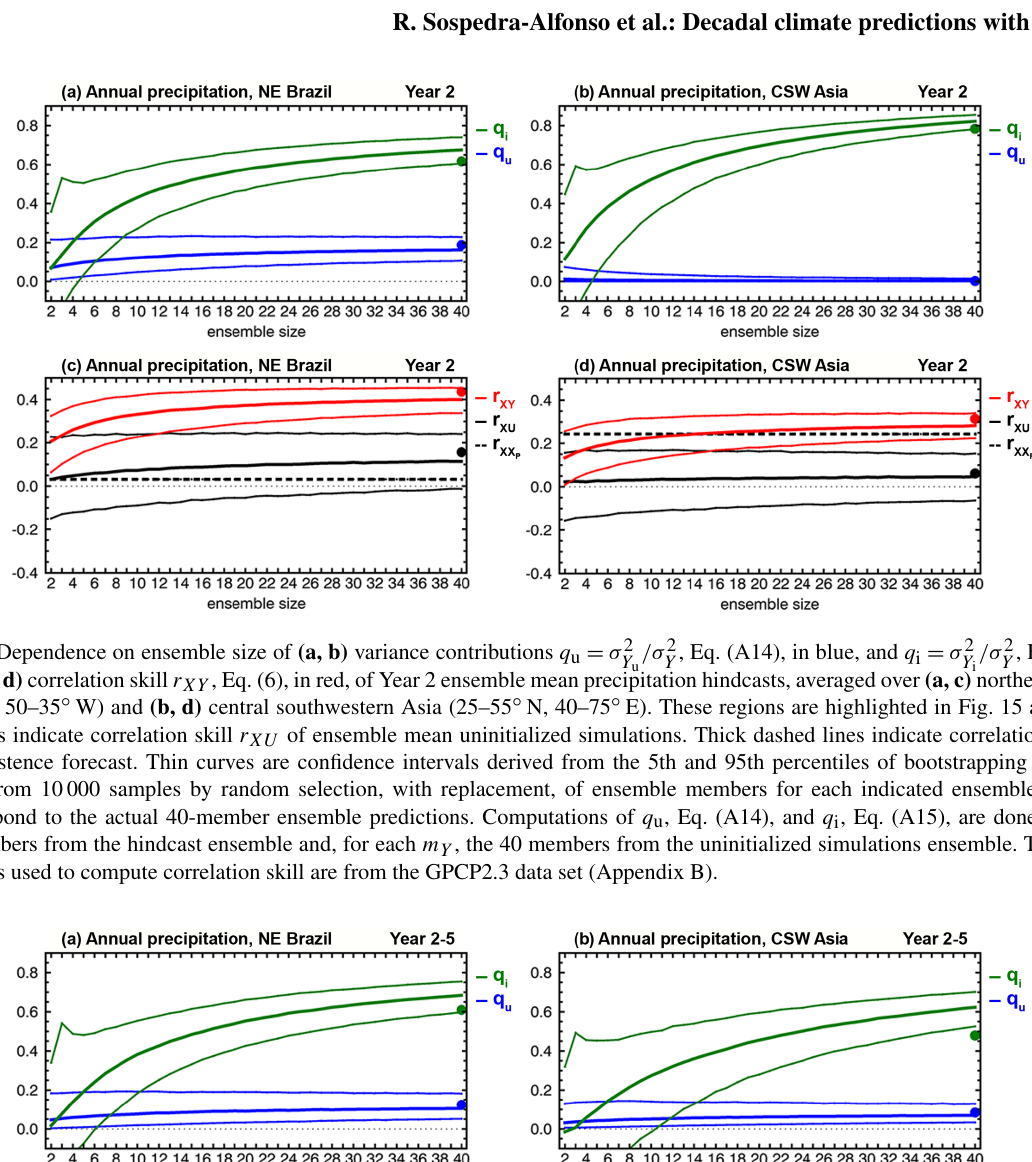
Figure 17. As in Fig. 16 for forecast Year